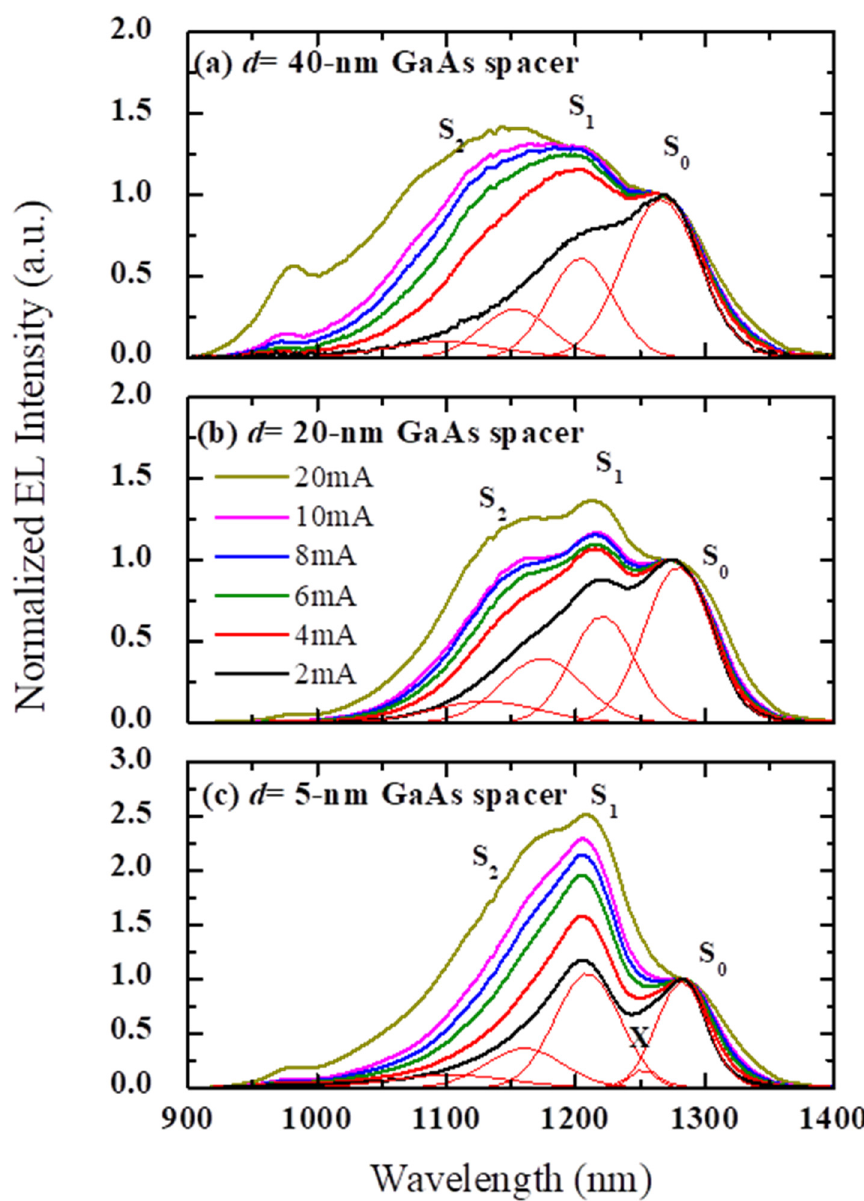
Figure 4. The normalized EL spectra for the p-i-n structure consisting of triple-layer In 0.75 Ga 0.25 As QDs with ( a ) d = 40 nm, ( b ) d = 20 nm, and ( c ) d = 5 nm.